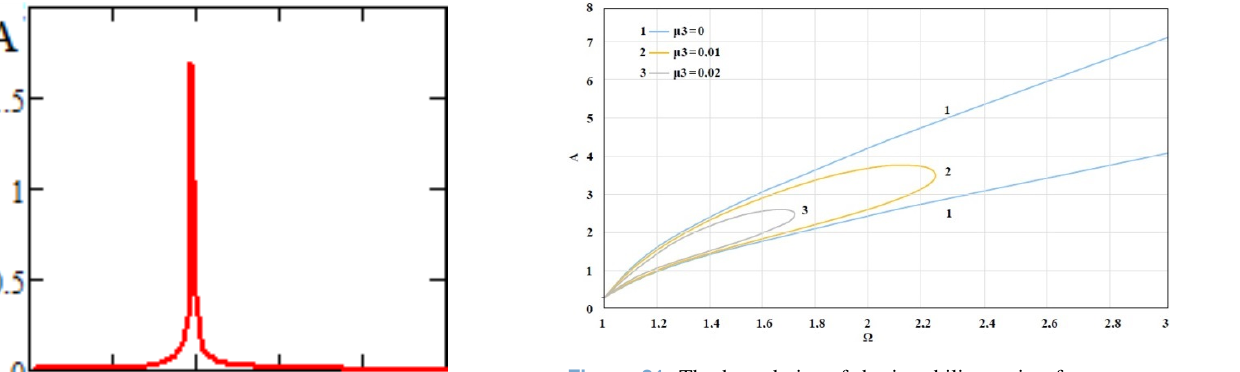
Figure 21. The boundaries of the instability region for a system with a coefficient of non-linear stiffness of the support K 3 = 0 . 2 with a linear viscous damping coefficient µ 1 = 0 . 1 and different values of non-linear viscous damping coefficient µ 3 .